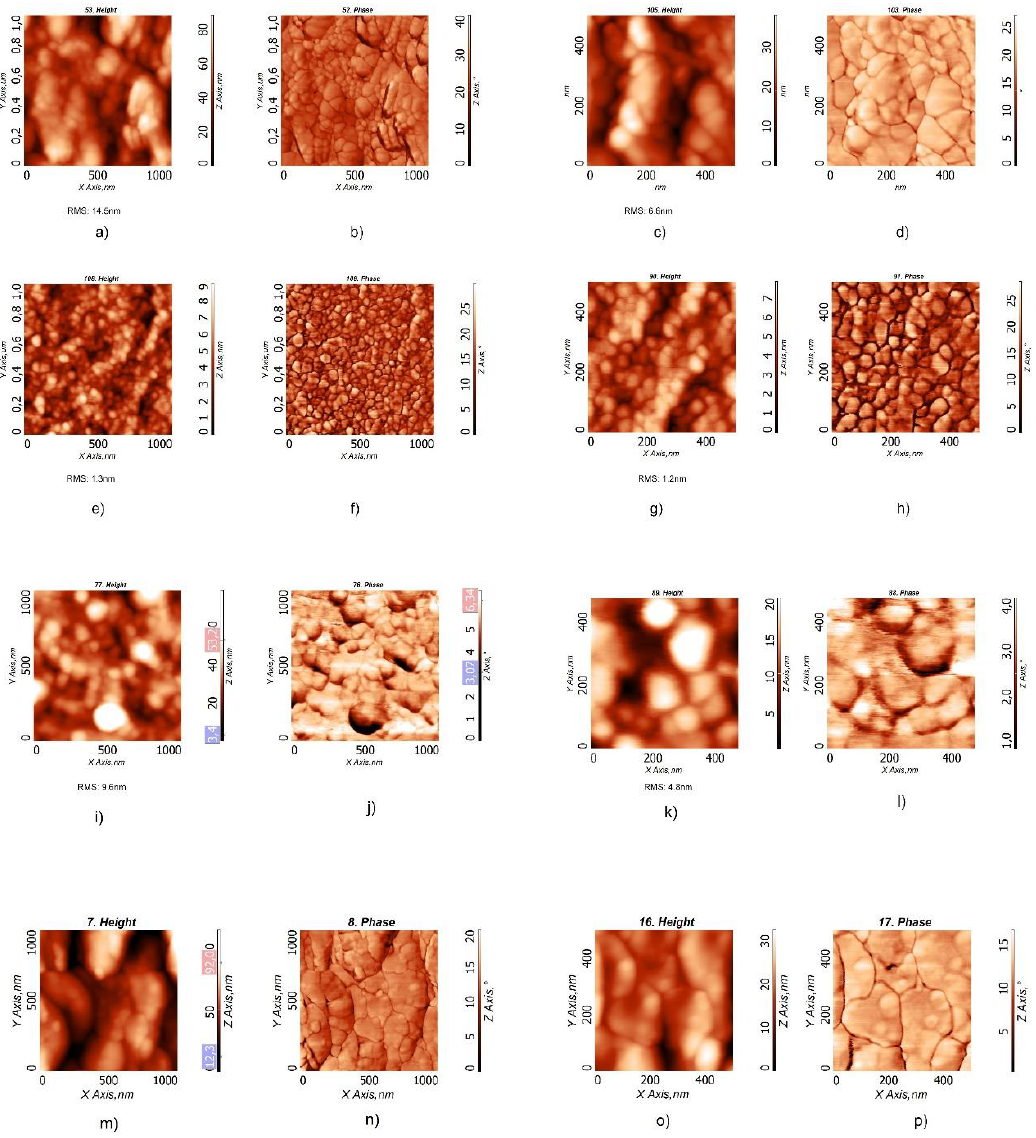
Figure 4. AFM images of films obtained from the aqueous dispersions, with two different magnifi- cations, of BCP2 bWPNPs ( a – d ), BCP5 bWPNPs ( e – h ), BCP15 bWPNPs ( i – l ) and BCP100 WPNPs ( m – p ). Table 3. Root mean square (RMS) values corresponding to the BCP2, BCP5, BCP15, and BCP100 bWPNPs (Figure 3a,e,i,p).